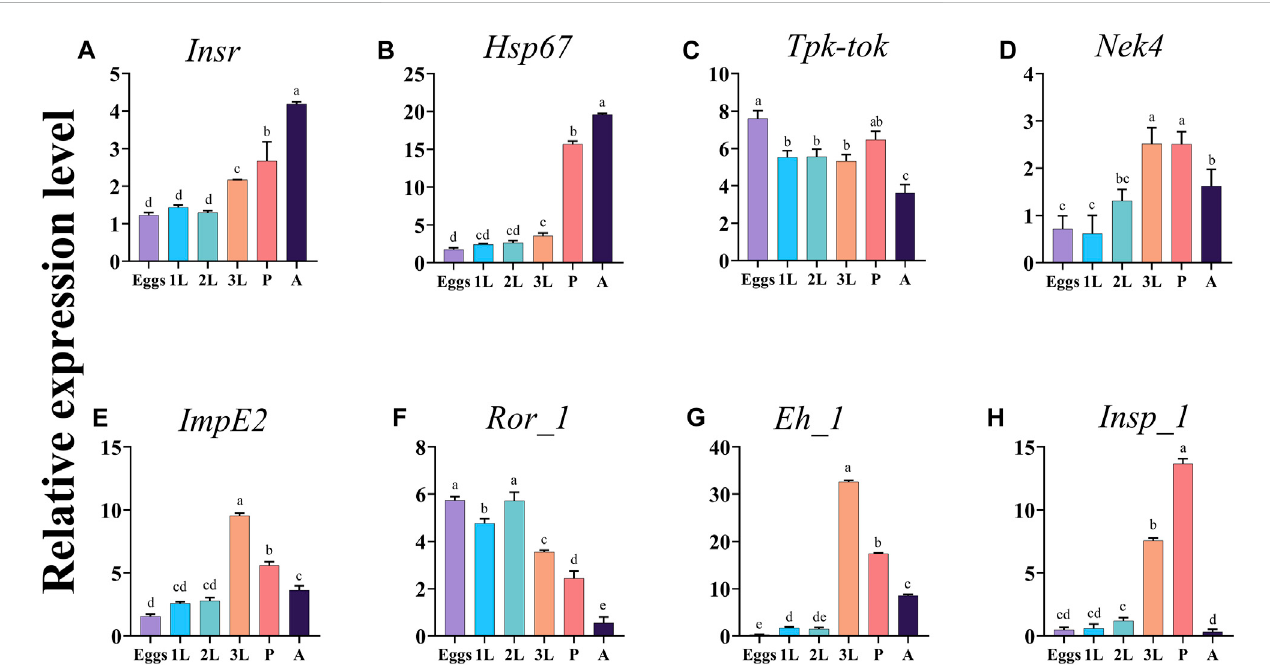
FIGURE 2 Expression pro fi les of the eight target genes Insr , Hsp67 , Tpk-tok , Nek4 , ImpE2 , Ror_1 , Eh_1, and Insp_1 in different developmental stages of Z. cucurbitae . Eggs, 1st instar (1L), 2nd instar (2L), 3rd instar (3L), Pupae (P) and Adults (A). Values represent means ± SD. Different letters above the bars indicate signi fi cant differences at p < .05 (Tukey ’ s tests). EF α 1 and Actin were used as internal controls and the 2 − ΔΔ CT method was used to calculate the gene relative expression